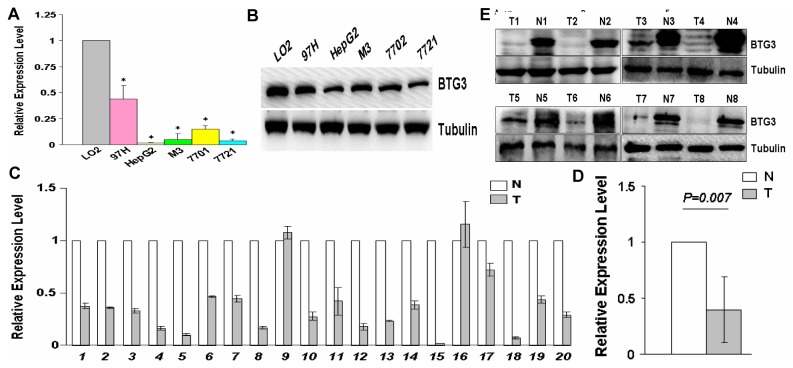
BTG3 is down-regulated in HCC cell lines and fresh HCC tissues.(A) Real-time RT-PCR analysis of BTG3 in six cell lines. The relative mRNA levels with the use of control LO2 were normalized to 1. (B) Western blotting analysis of BTG3 in six cell lines. Tubulin was shown as a control. (C) Real-time PCR analysis of BTG3 expression in 20 paired HCC tissues. The relative mRNA levels with the use of control normal livers were normalized to 1. (D) Real-time PCR analysis of BTG3 expression in all cases of HCC tissues and adjacent normal livers. (E) Western blotting analyses of BTG3 expression in 8 paired HCC tissues. Tubulin was shown as a control. N=normal mucosa and T=tumor.